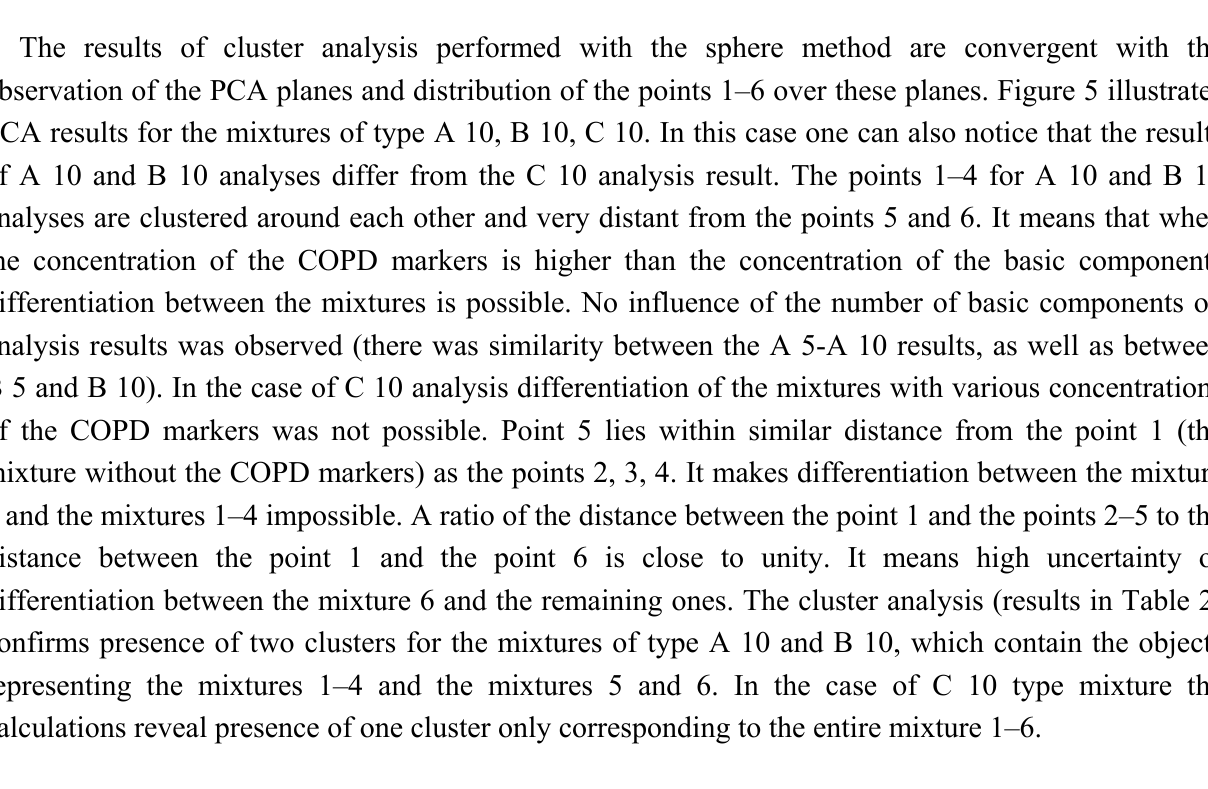
Table 2. Summary information obtained based on cluster analysis employing sphere method to evaluation of the number of object clusters in multidimensional space of